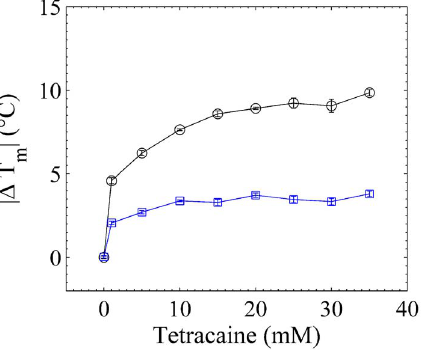
Figure 4. Calorimetric study of DPPC/DPPA liposomes. Tetra- caine-caffeine experiment for several doses of tetracaine: shift of the melting temperature with respect to the control sample of the tetracaine doped liposomes at various doses with (squares) and without (circles) 111 mM of caffeine. Since D T m is always negative (the final temperature is always lower than the initial one), we plot its absolute number to illustrate the saturation of the shift at high concentrations of tetracaine. Note that, at the doses reported in this work, D D T m D exhibits a Michaelis-Menten like behavior in both cases.